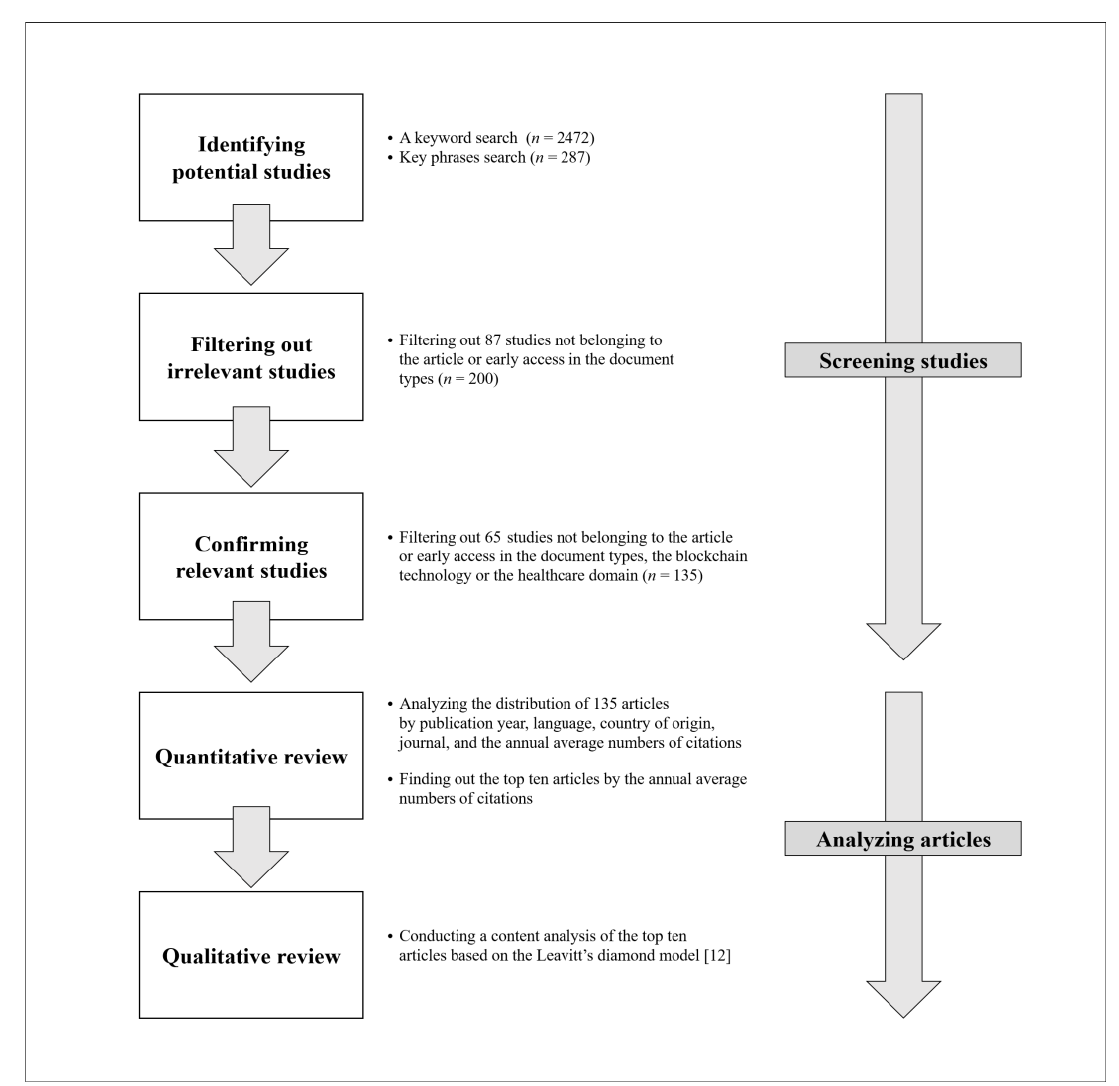
Figure 1. Review flow chart.